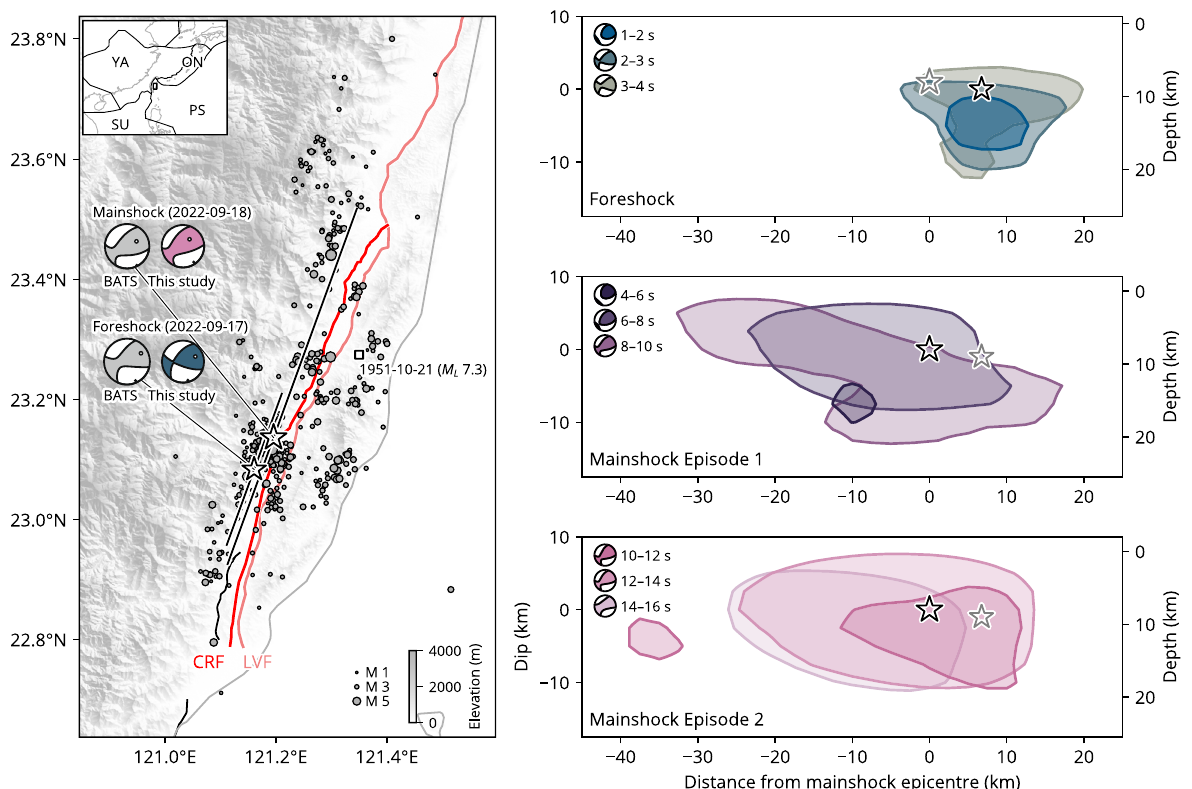
Figure 1. Overview of the 2022 Taitung earthquake sequence. The left panel shows the earthquake sequence (2022-09-17 to 2022-09-21) determined by the Central Weather Bureau (CWB) in Taiwan 1 . The size of the circle scales with its magnitude (see legend). The two stars show the largest foreshock and the mainshock epicentres, and black lines show top of the model plane used for our inversion. The square shows the epicentre of the M L 7.3 earthquake on 21 October 1951 4 . The beachballs are the moment tensor solutions obtained by the Broadband Array in Taiwan for Seismology 3 and this study. The dots on the beachball are the P and T axes. The light and dark red lines correspond to the Longitudinal Valley fault (LVF) and the Central Range fault (CRF) 7 . The topography is from the SRTMGL3 8 . The text denotes the plate name: YA; Yangtze, SU; Sunda, ON; Okinawa, and PS; Philippine Sea plates 9 . The right panels show the space distribution of the potency-rate density of the foreshock and the mainshock projected onto the mainshock model plane, viewed from the west-northwest. The contours in these figures are above 40% of maximum potency-rate density for each event: > 0.26 m/s for the foreshock and > 0.14 m/s for the